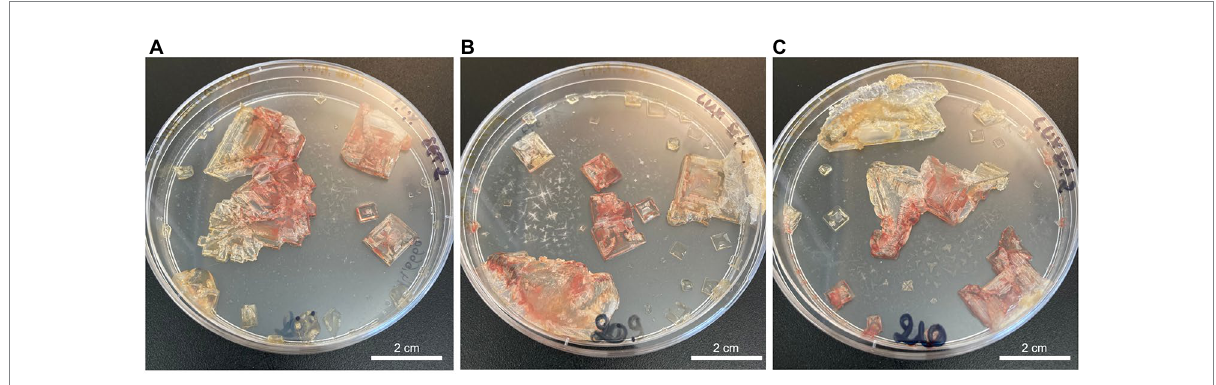
FIGURE 1 TNPA laboratory-grown halite crystals internally inoculated with Halobacterium salinarum cells observed after two months of incubation at 37 ° C for crystallization replicates 1–3 ( A–C ,